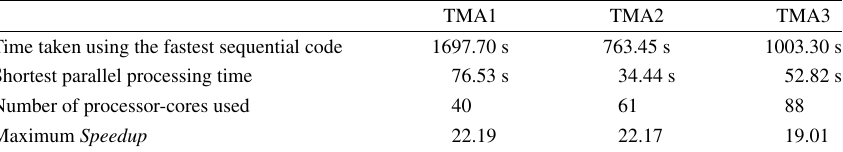
Statistics for the overall processing time for biomarker quantification over the 3 TMA virtual